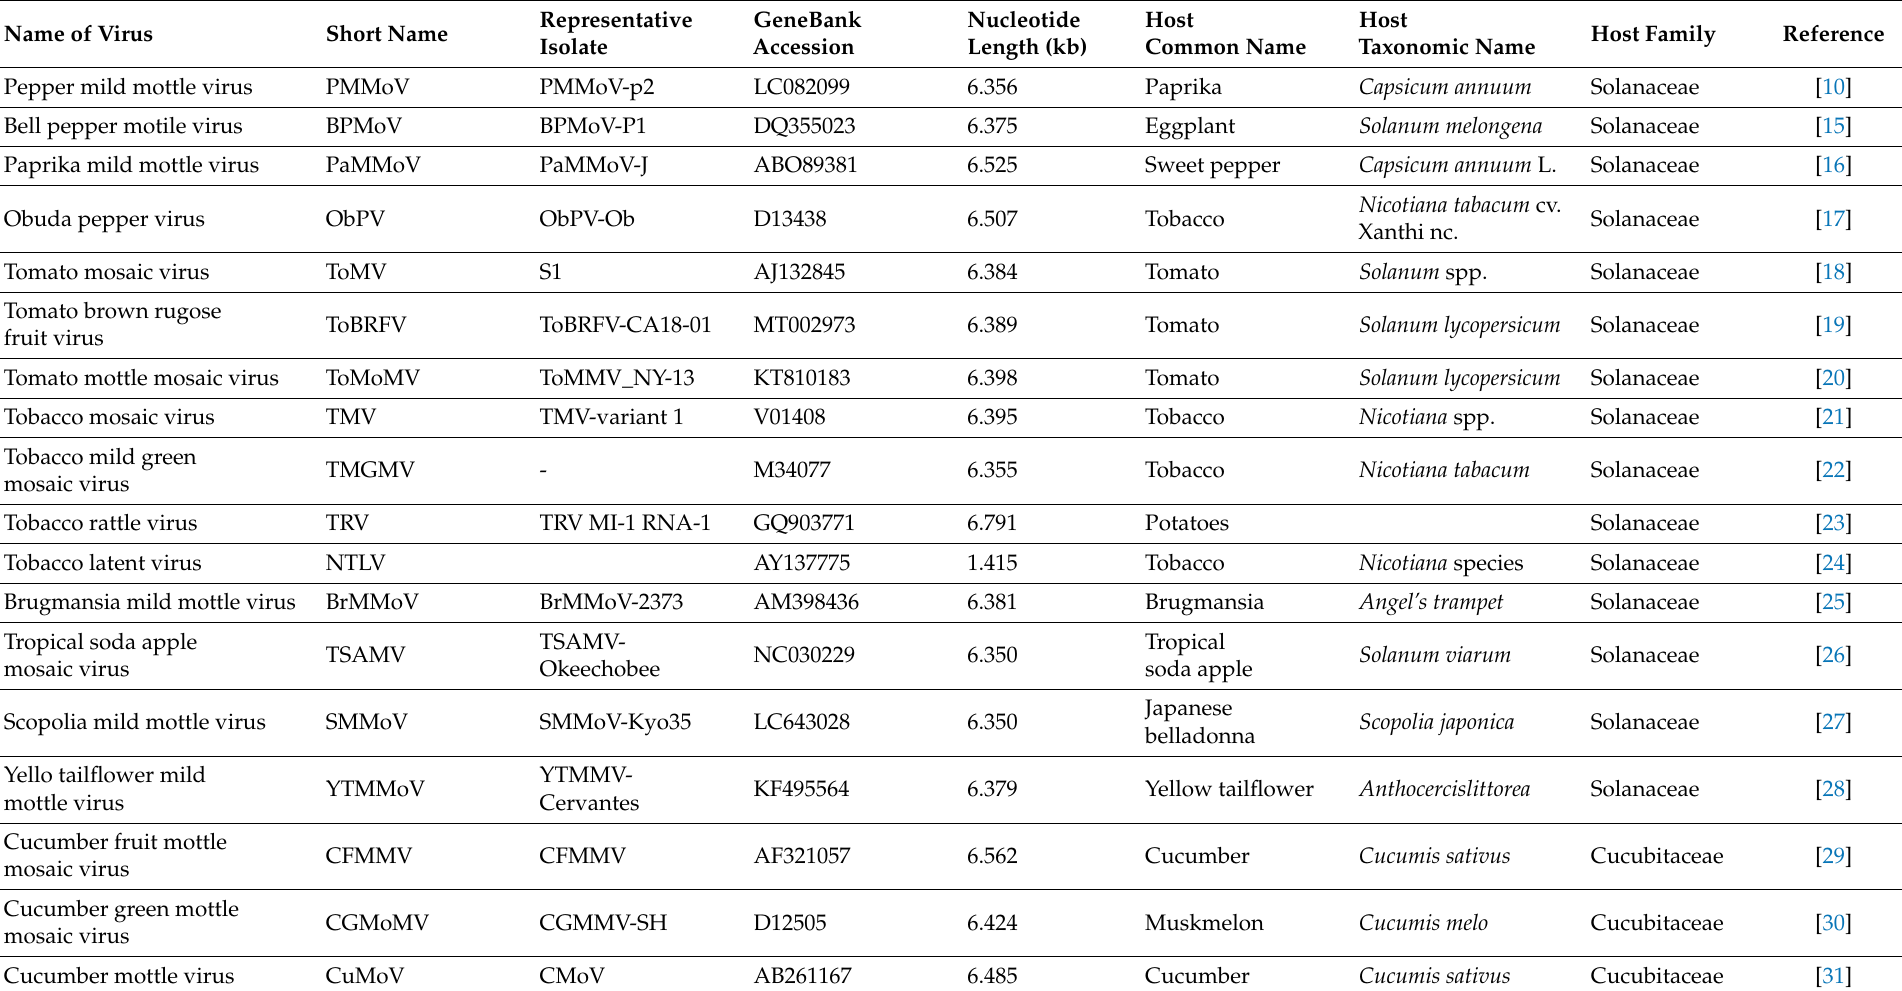
Table 1. Plant viruses belonging to the genus Tobamovirus of the family Virgaviridae